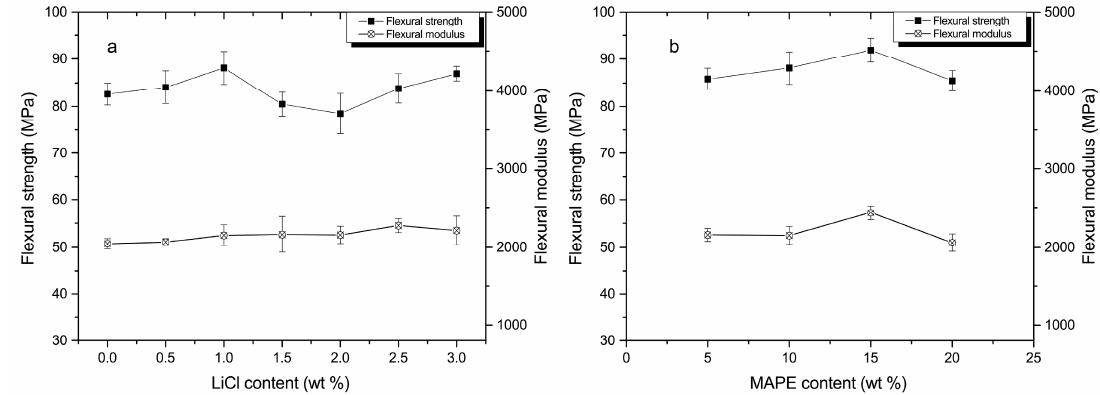
Figure 2. Flexural properties of composites: (a) in various LiCl contents; and (b) in various MAPE contents.